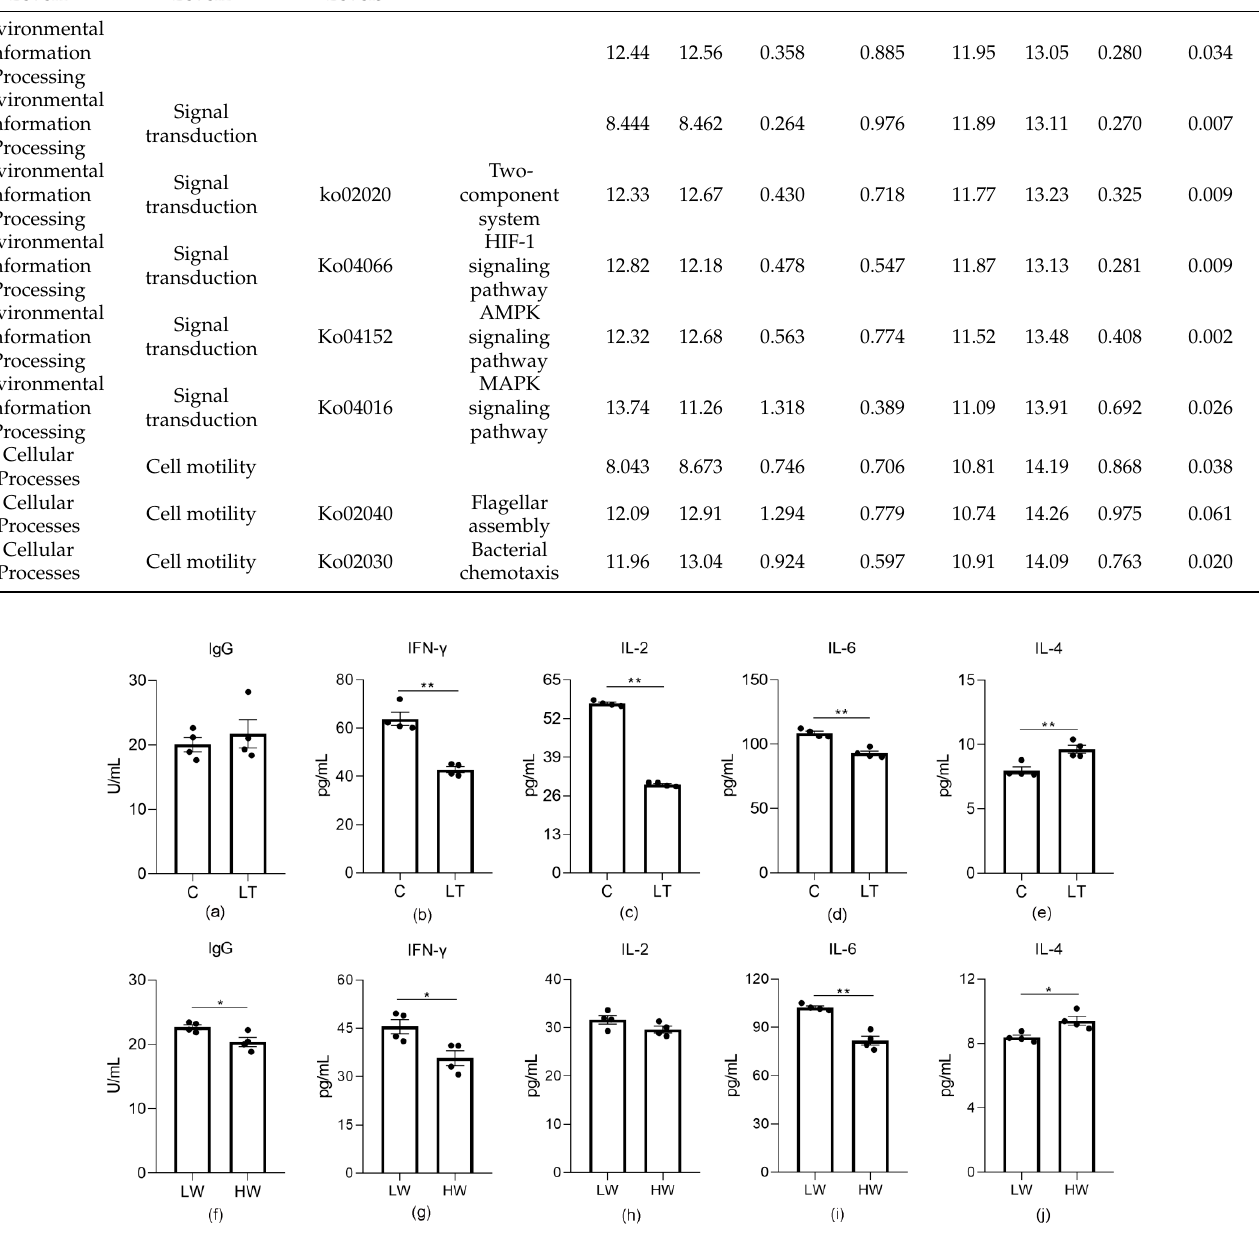
Figure 5. Effects of cold stress on immune factors in sheep. ( a – e ) Change of factors in the C and LT groups. ( a ) IgG. ( b ) IFN- γ . ( c ) IL-2. ( d ) IL-6. ( e ) IL-4. ( f – j ) Change of factors in the LW and HW groups. ( f ) IgG. ( g ) IFN- γ . ( h ) IL-2. ( i ) IL-6. ( j ) IL-4. *, p < 0.05; **, p < 0.01. Table 3. Effects of cold stress on antioxidant indices in sheep.